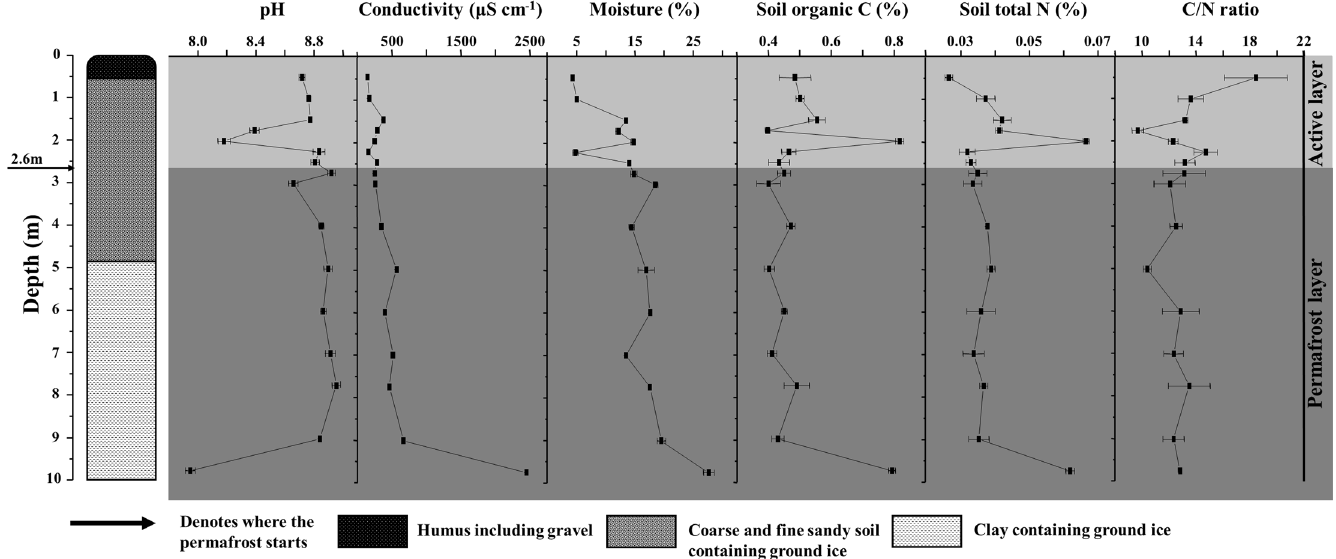
Fig 1. Schematic diagram of the permafrost core and the associated physiochemical characteristics of different-depth samples. Error bars represent means ± the standard error (n =